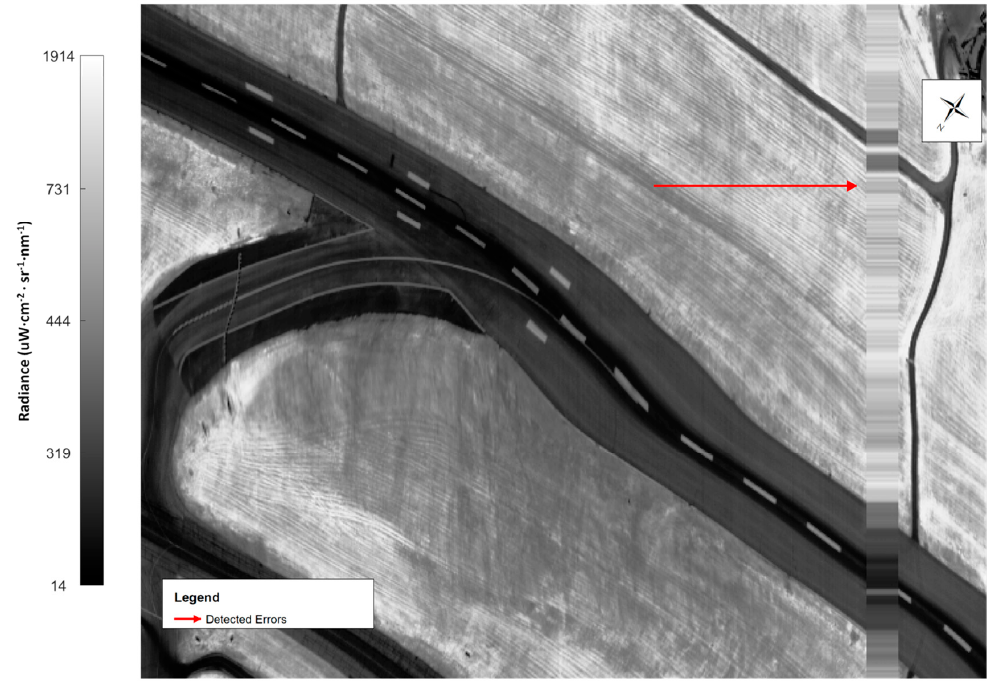
Figure 16. Histogram-equalized SASI imagery (24 June with the refined processing) at 1003 nm. An error across Pixels 548–564 is identified by the red arrow.